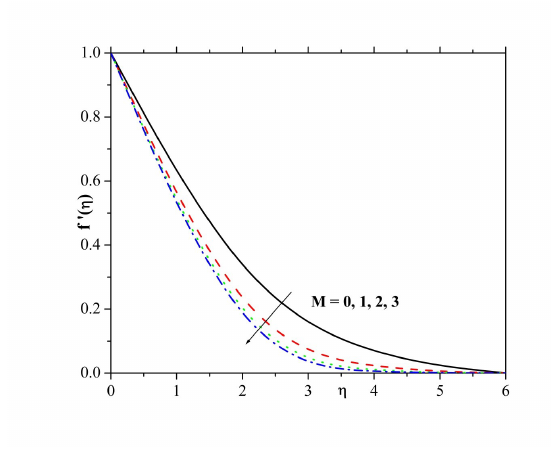
Fig. 2: Influence of M on f ′ ( η ) .